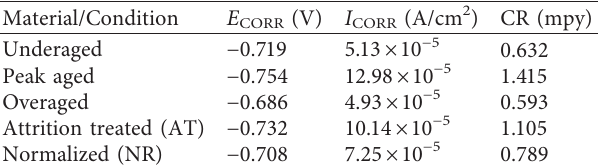
Figure 6: Potentiodynamic polarization plot of 6351 Al alloy in Red Sea water. Table 2: The corrosion characteristics of 6351 Al alloy in Red Sea water.